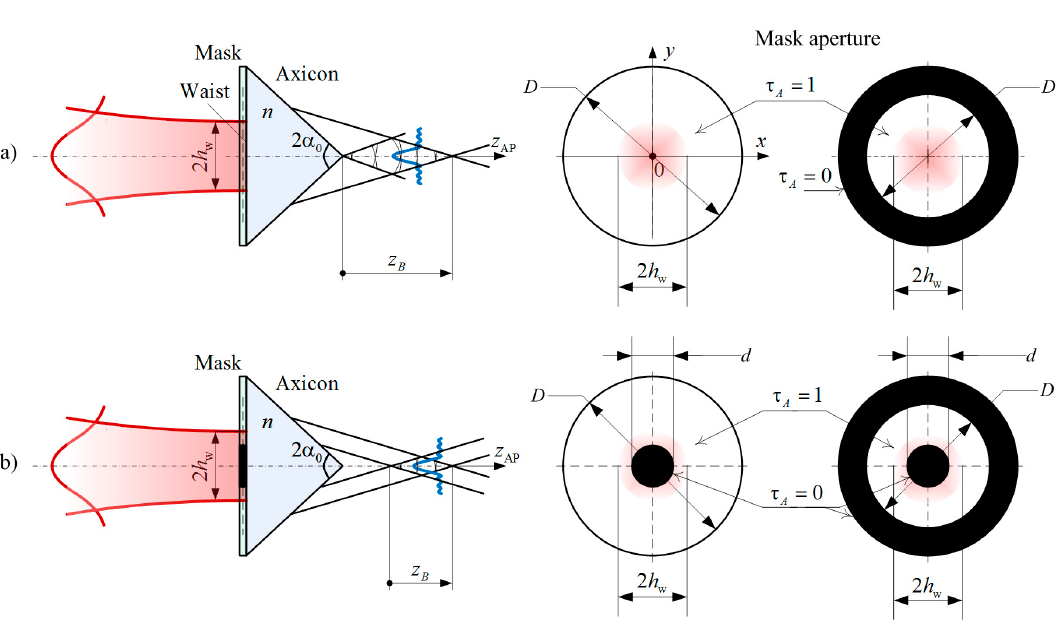
Figure 1. Schemes for the formation of a zero-order Bessel beam with a quasi-rectangular dependence of axial intensity: ( a ) the Bessel zone starts right after the axicon; ( b ) the Bessel zone is moved away from the axicon. 2 h w —waist diameter of the Gaussian beam, 2 α 0 —apex angle axicon, n —refractive index axicon, z AP —analysis plane after the axicon, z B —length of the Bessel zone, D—clear aperture of the binary mask, d—diameter of the inner aperture of the mask, τ A —amplitude transmittance.